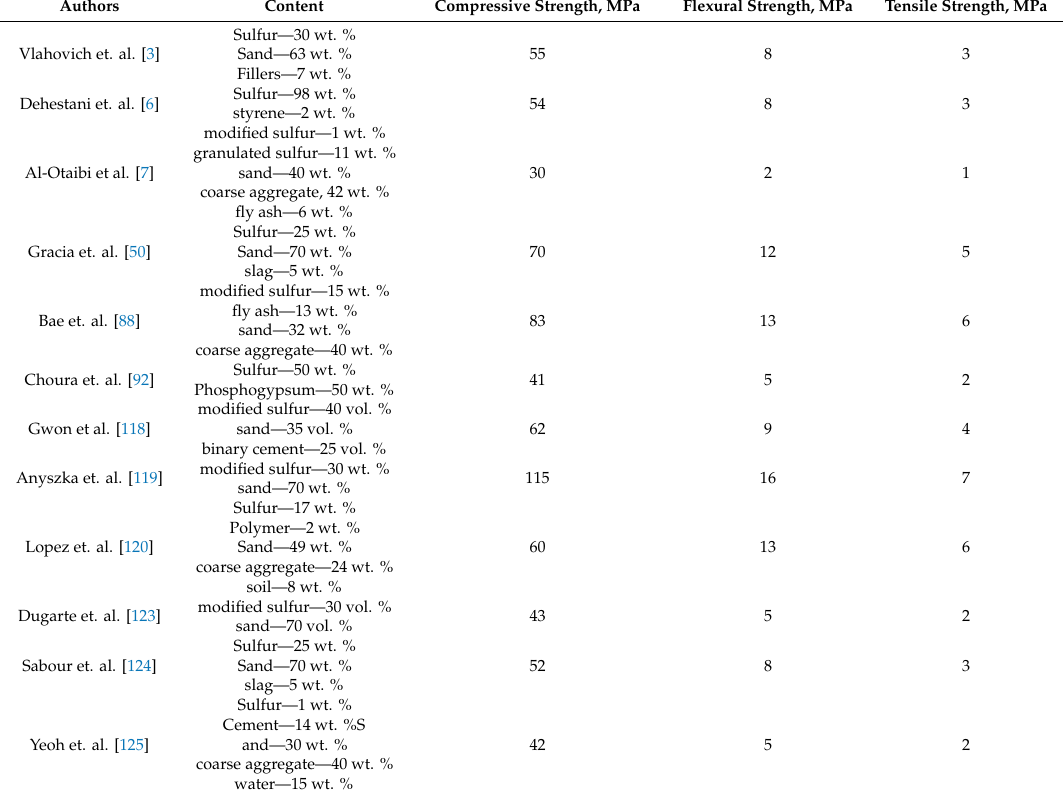
Table 6. Characteristics of strength of various sulfur-based